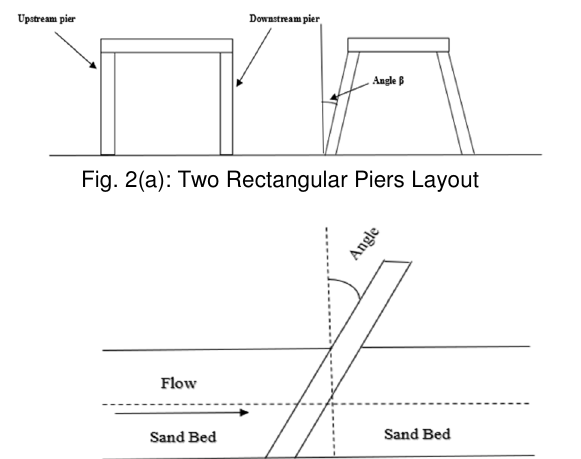
Fig. 2(b): Inclined Rectangular Pier Position Inside Flume